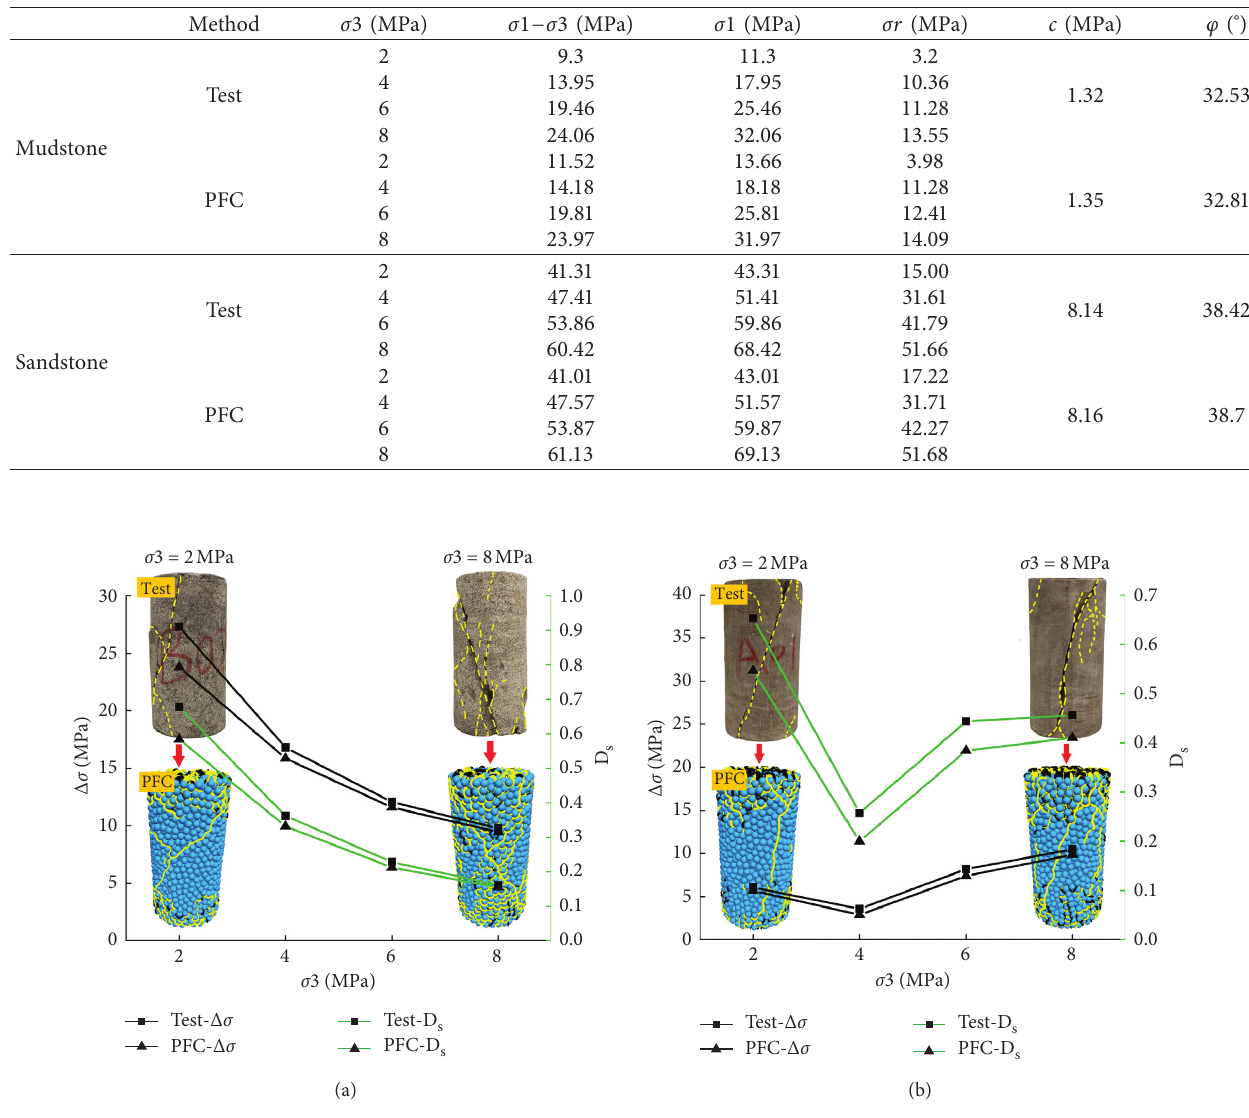
s , and failure characteristics. (a) Sandstone. (b) Mudstone.